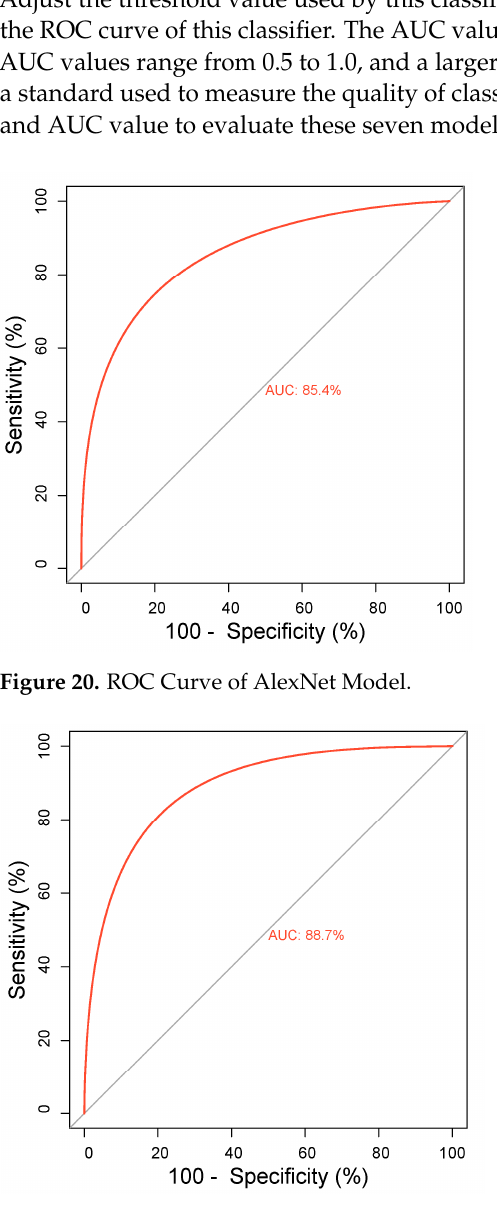
Figure 22. ROC Curve of Lian-VGGNet Model.